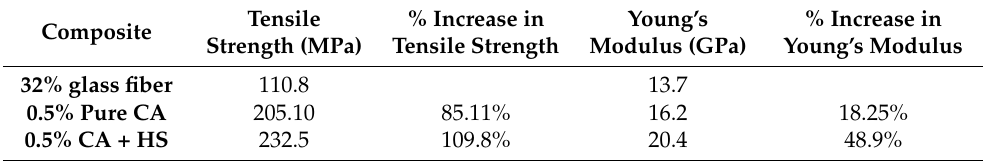
Figure 15. Tensile test result—0.5% volume fraction (CA + HS). Table 6. Average tensile strengthen properties of nanofiber mat hybrid composites.